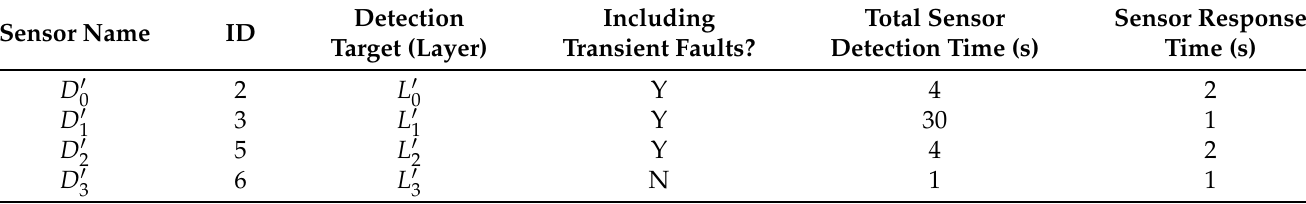
Table 5. The updated sensor information table of the new four-layer